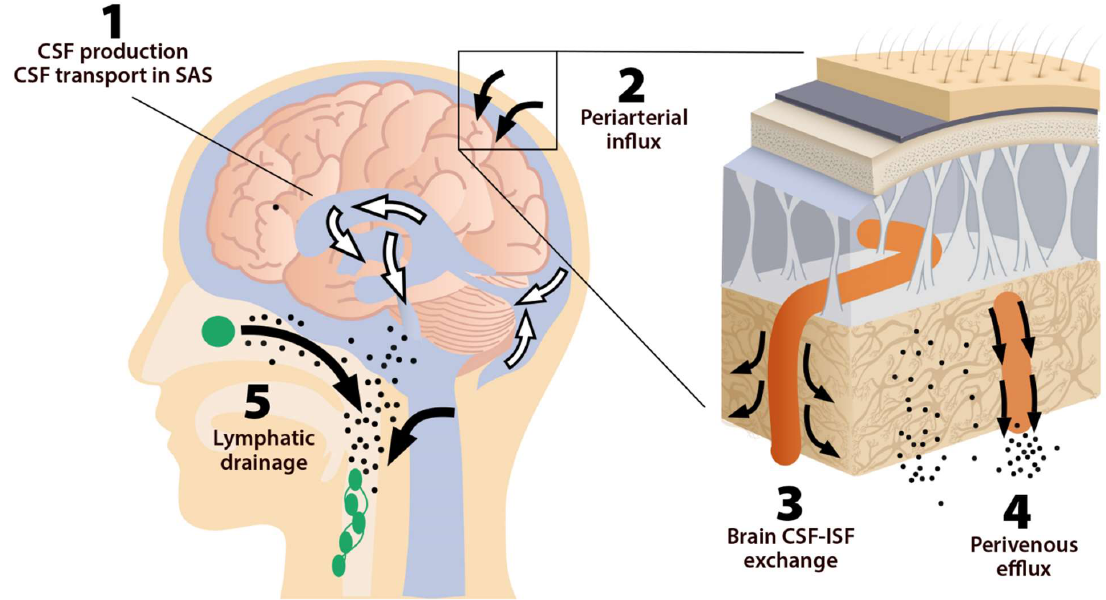
Figure 1. The five components of the glymphatic system. The fluid transport pathway is divided into five distinct segments: (1) cerebrospinal fluid (CSF) is produced by the choroid plexus and likely by extrachoroidal sources (capillary influx and metabolic water production); (2) arterial wall pulsatility drives CSF deep into brain along perivascular spaces; (3) CSF enters the brain parenchyma supported by aquaporin-4 (AQP4) water channels and disperses within the neuropil; interstitial fluid (ISF) mixes with CSF, (4) accumulates in the perivenous space, and drains out of the brain via (5) meningeal and cervical lymphatic vessels, as well as along cranial and spinal nerves Fluids from both the brain and the cribriform plate drain into the cervical lymphatic vessels, which then empty into the venous system at the level of the subclavian veins. The olfactory/cervical lymphatic drainage route is the primary bulk flow pathway.